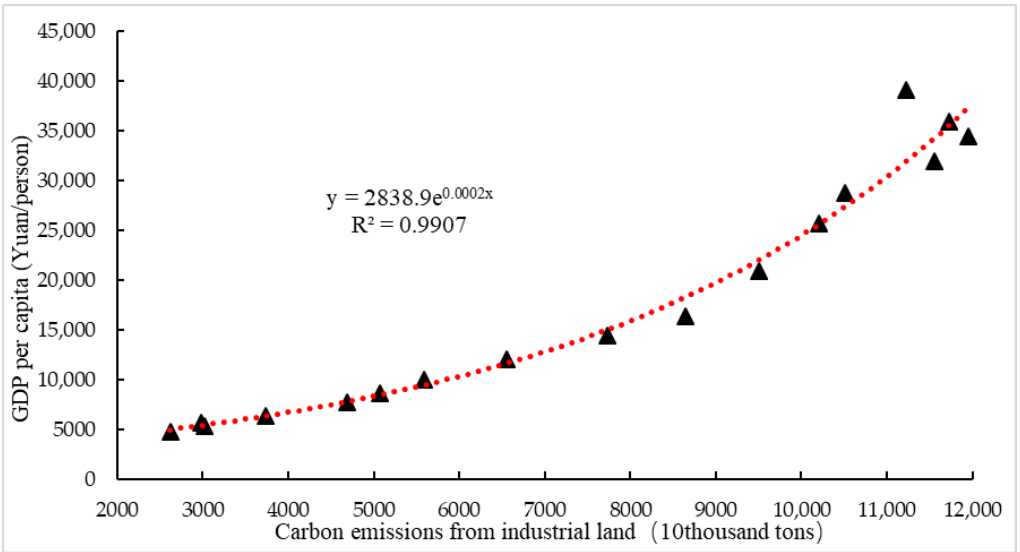
Figure 4. Relationship between CEIL and GDP per capita in Anhui Province from 2000 to 2016.